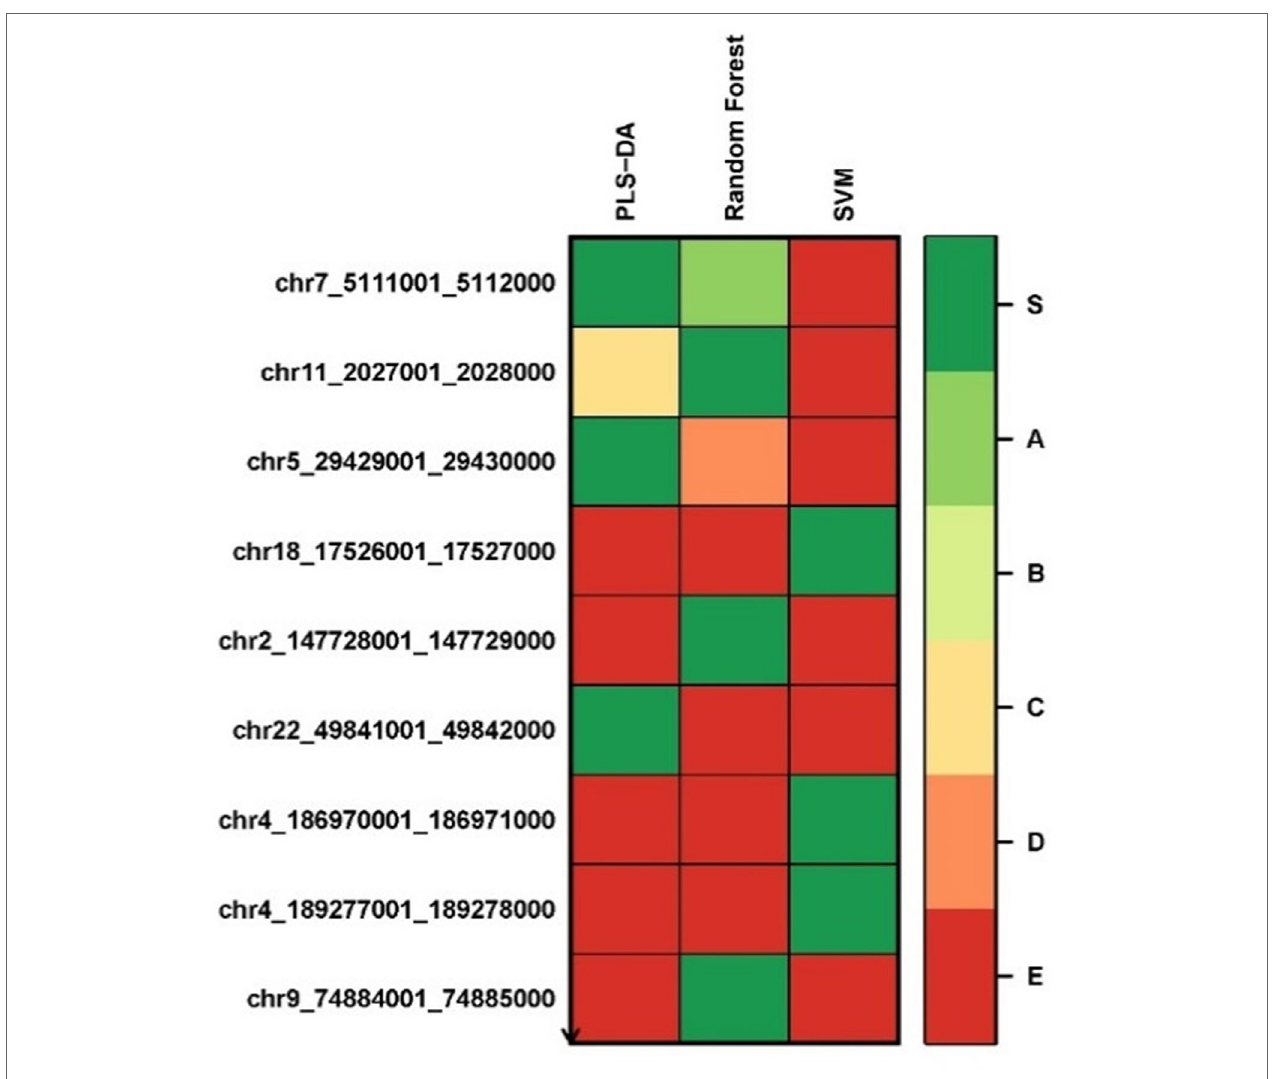
FIGURE 6 | Methylated region tier plot from biosigner using methylomics data; S, signature genes; A–E=A is a higher tier, and E is a lower tier.